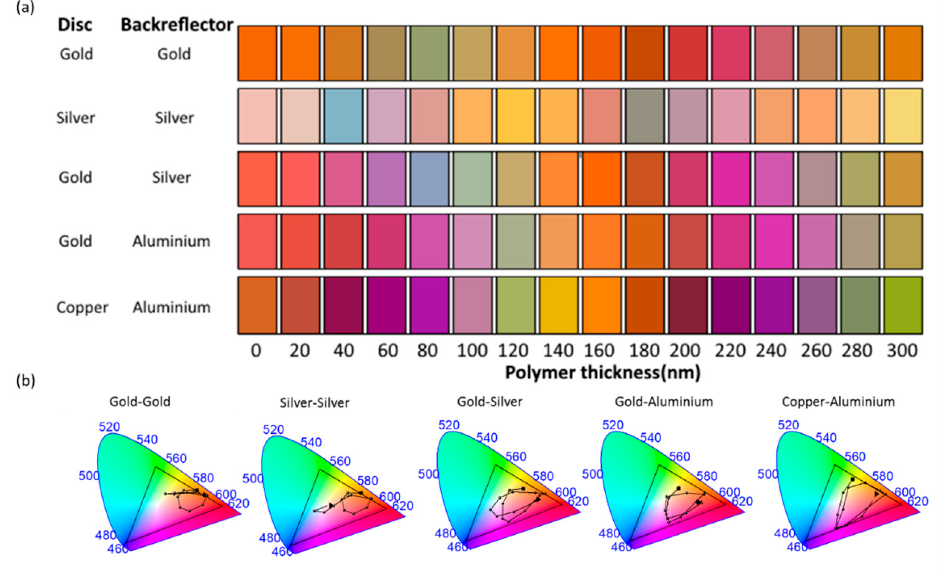
Figure 6. ( a ) Generated colour as a function of polymer layer thickness for different metal disc and back-reflector combinations. ( b ) CIE colour-space maps for each combination as a function of polymer thickness.